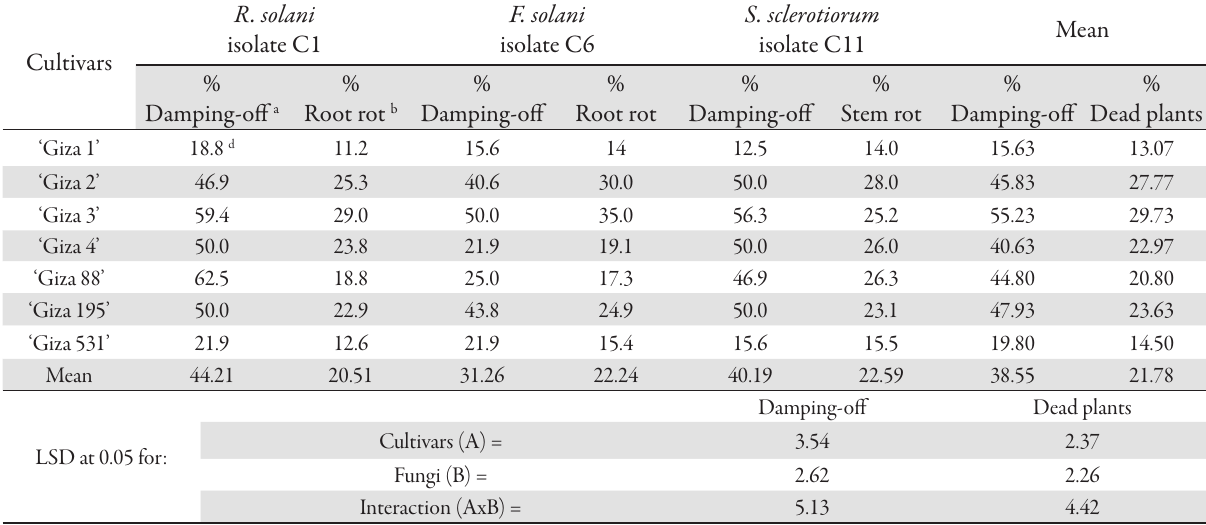
Tab. 2. Varietal response of seven chickpea cultivars towards the tested fungi, greenhouse experiment